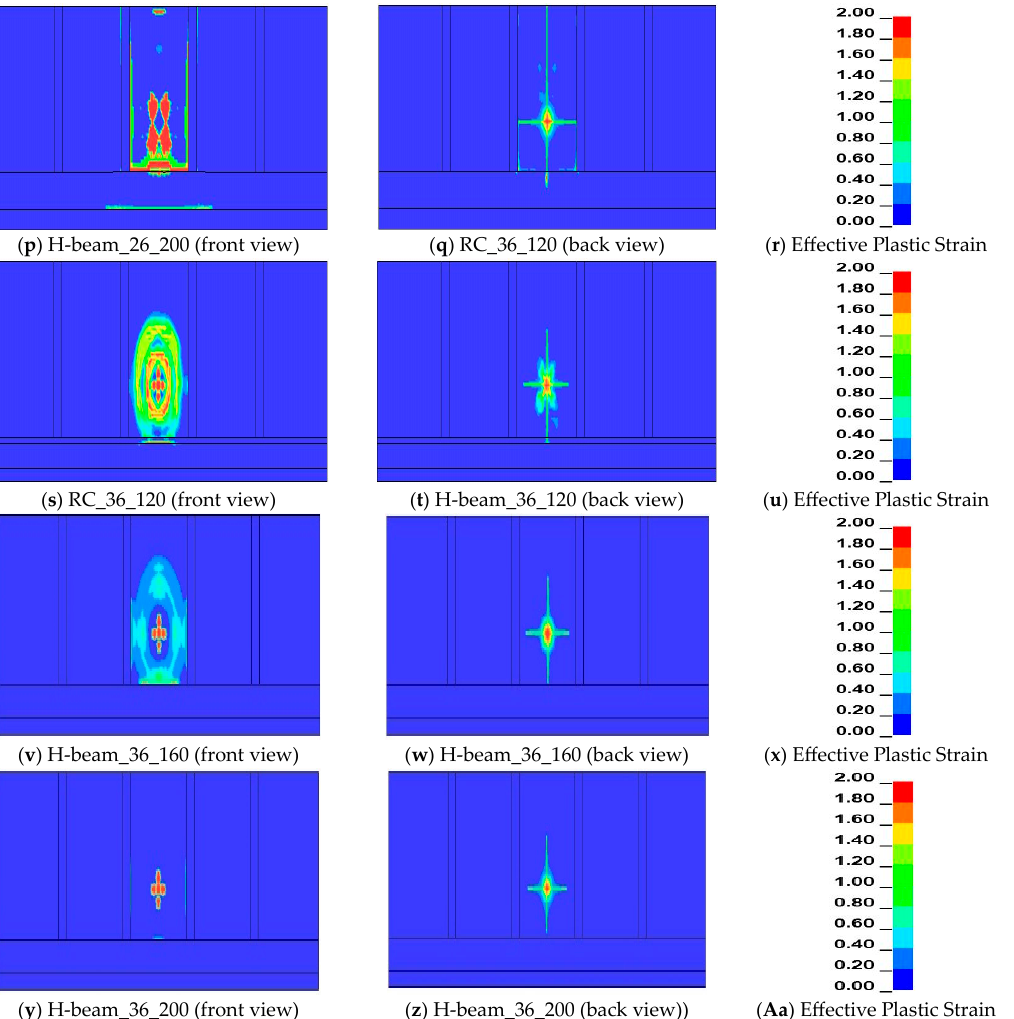
Figure 13. E ff ective plastic strain on composite structure protection wall with di ff erent thickness and stand-o ff distance during 30 kg of Hydrogen Gas